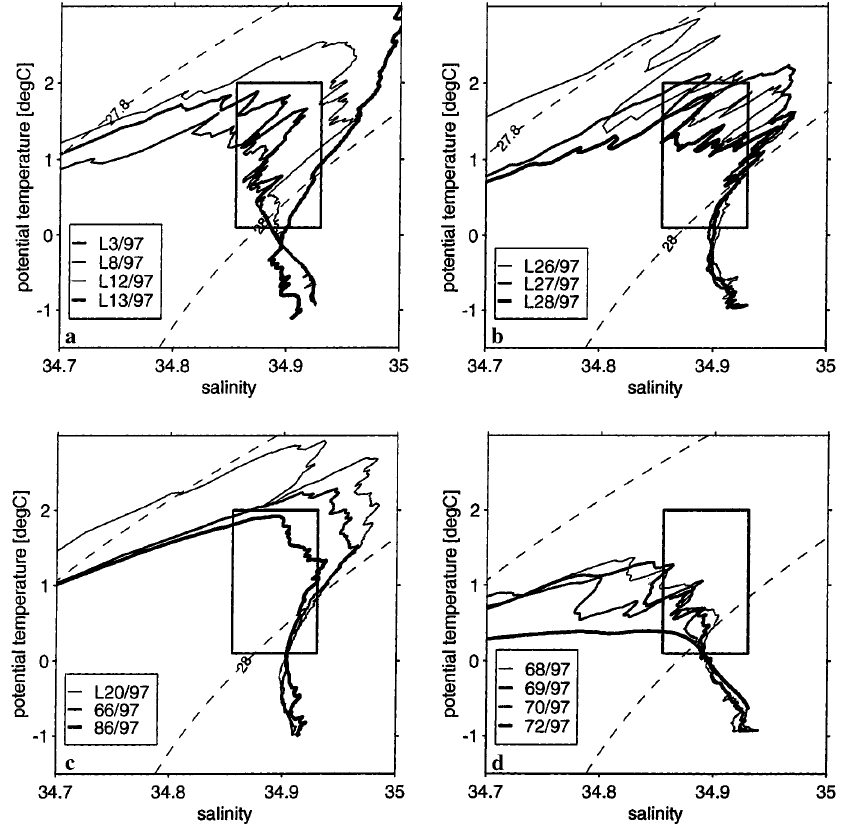
Fig. 10a–d. Q -S diagrams showing the in- terleaving structures observed a on section I at the Greenland slope, and b on section IV west of the Yermak Plateau. c the evolution of the inflow around the Yermak Plateau, and d the interleaving observed on section II. The inserted boxes are the same as in